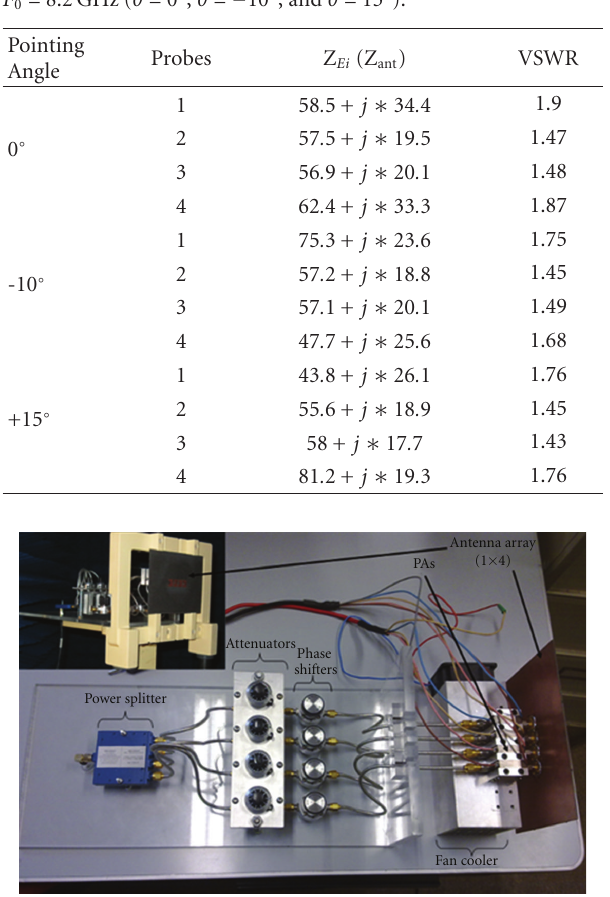
Table 4: Calculated impedances for each antenna in the array 1 × 4